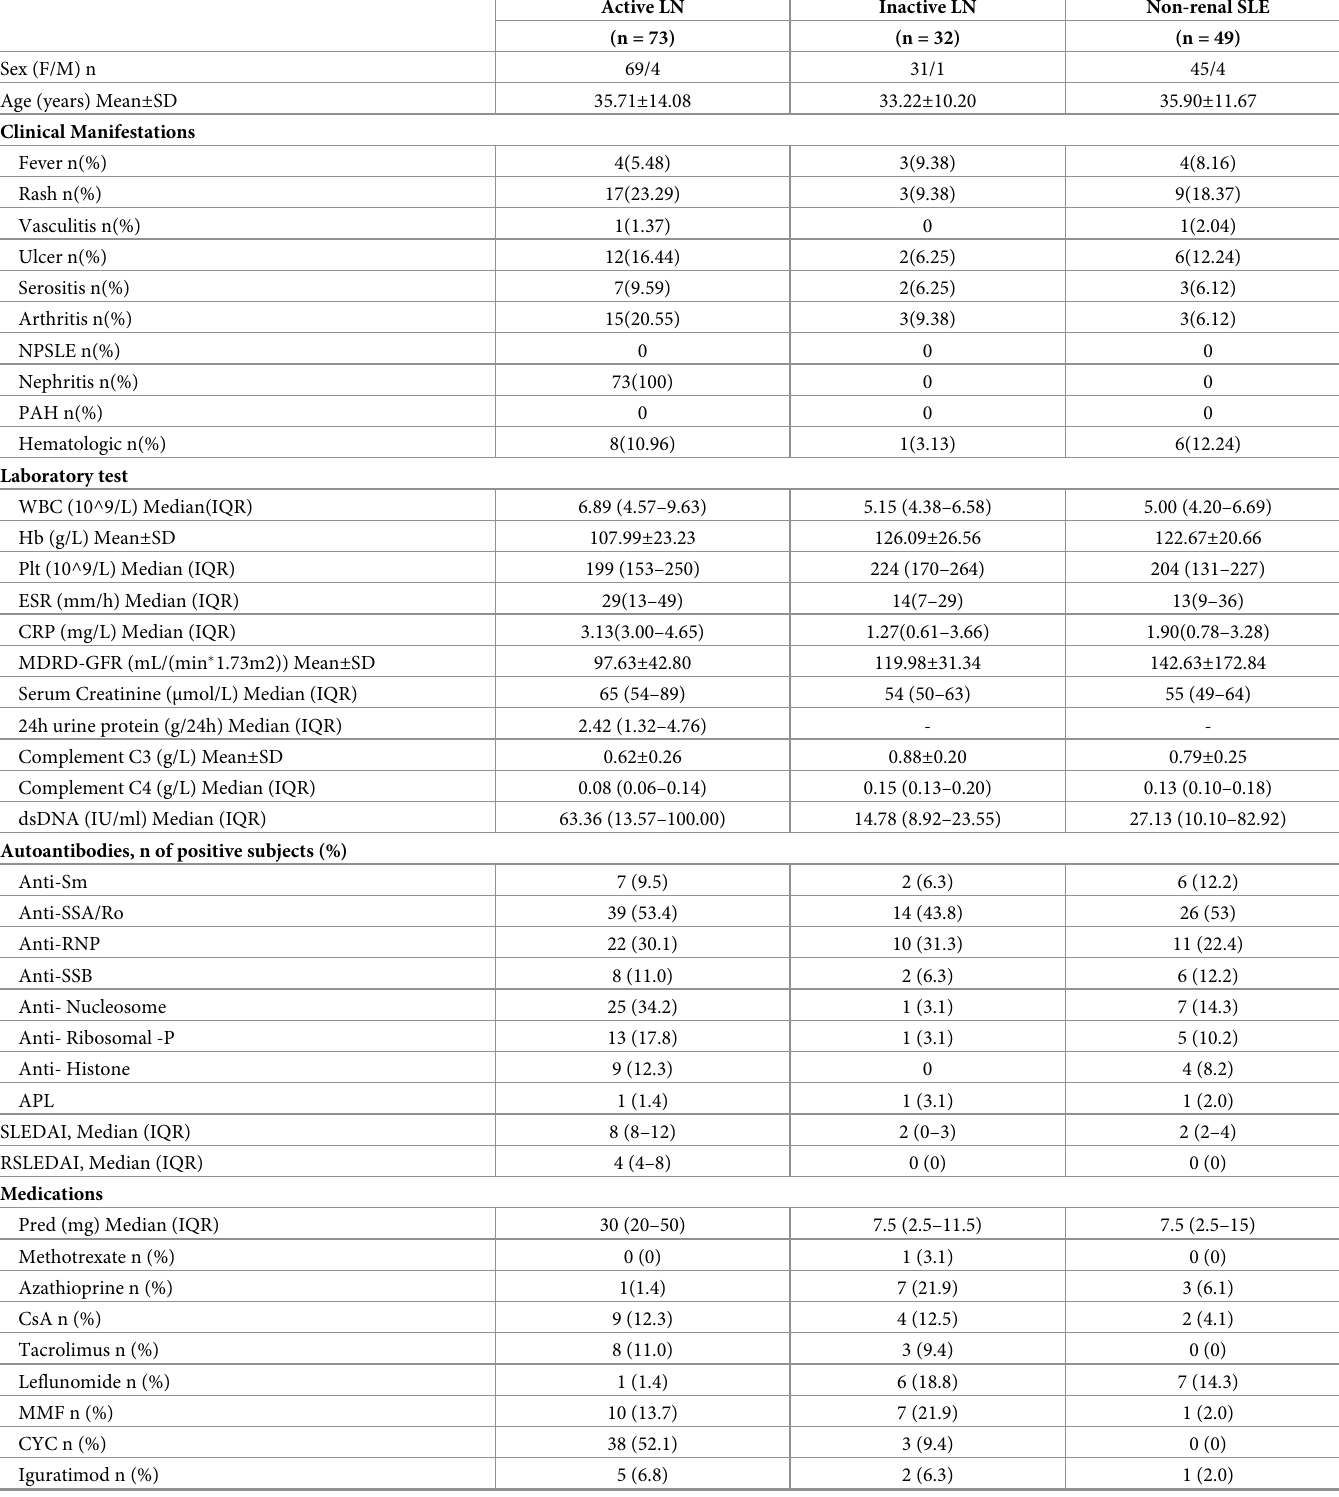
Table 1. Demographic and clinical characteristics of SLE